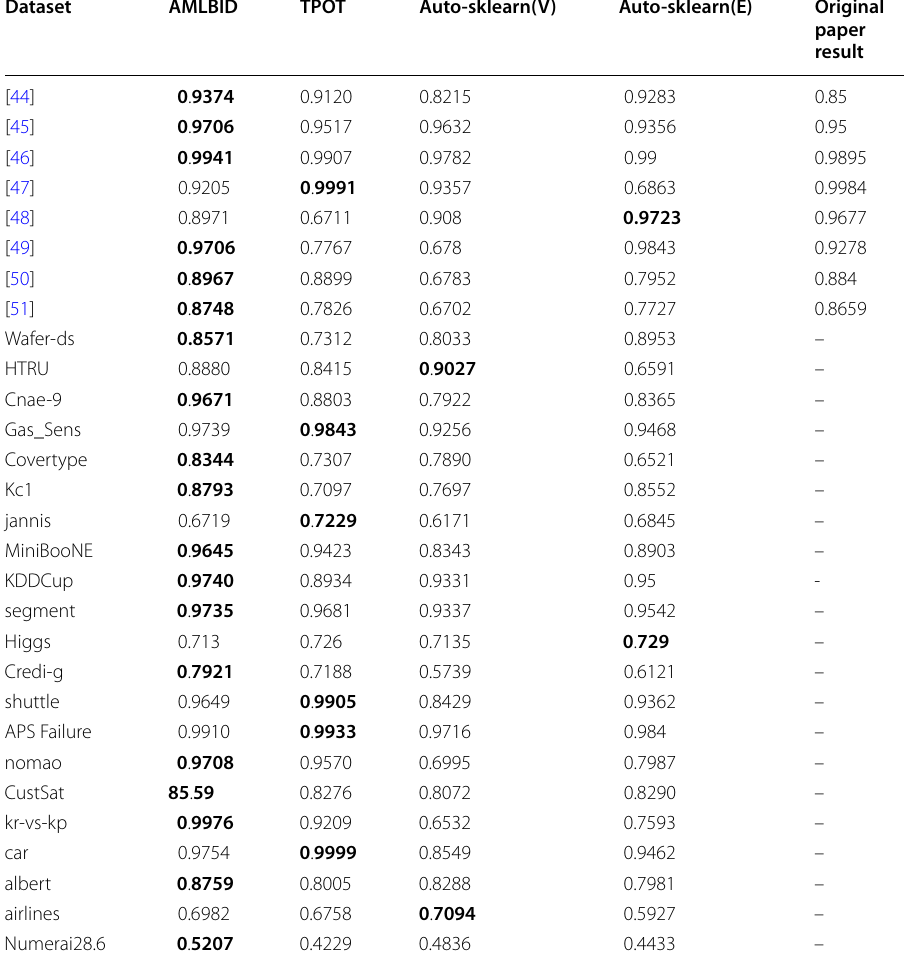
The best performances among all AutoML frameworks are highlighted in